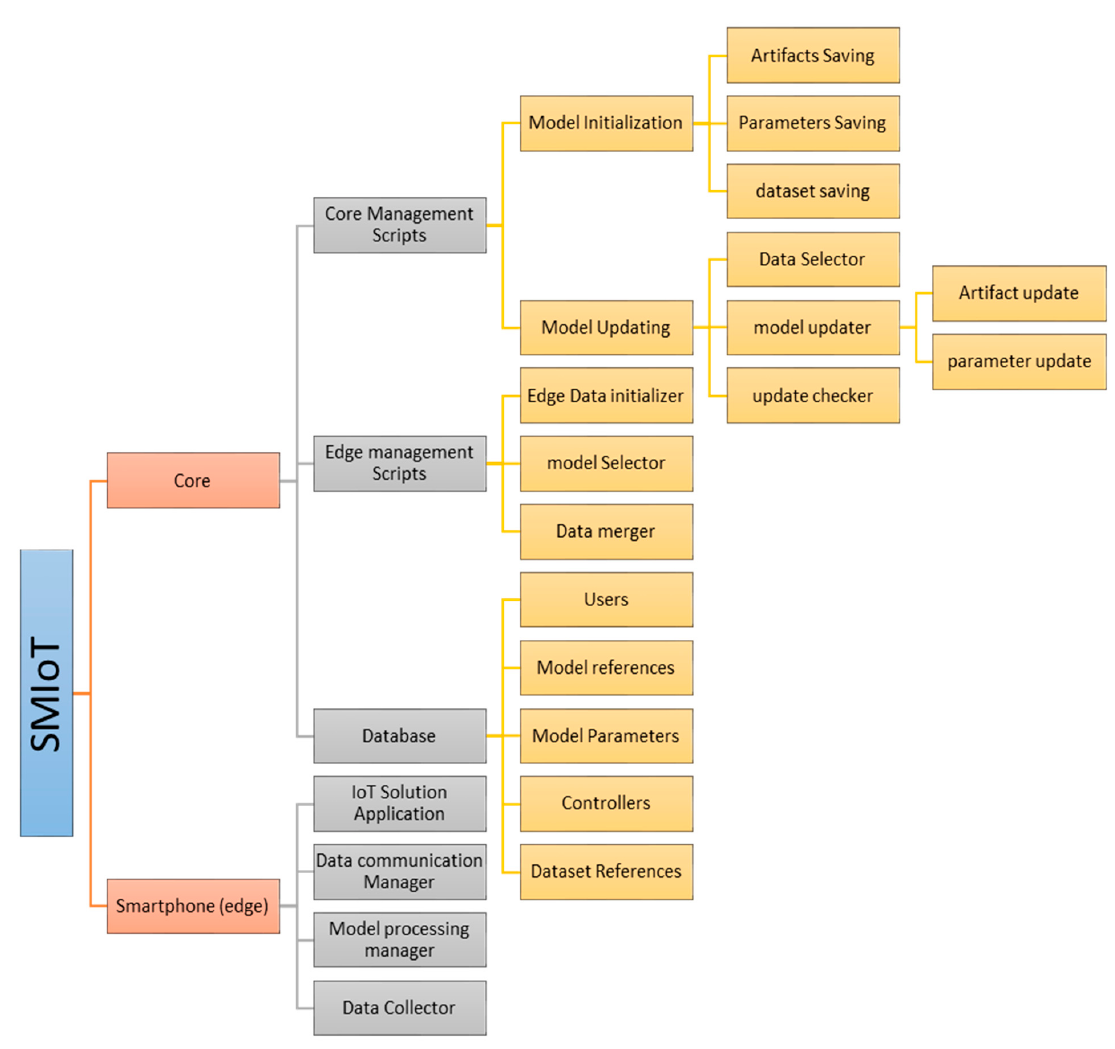
Figure 3. A Detailed structure of the SMIoT architecture showing all components for both core and edge (smartphone) devices.